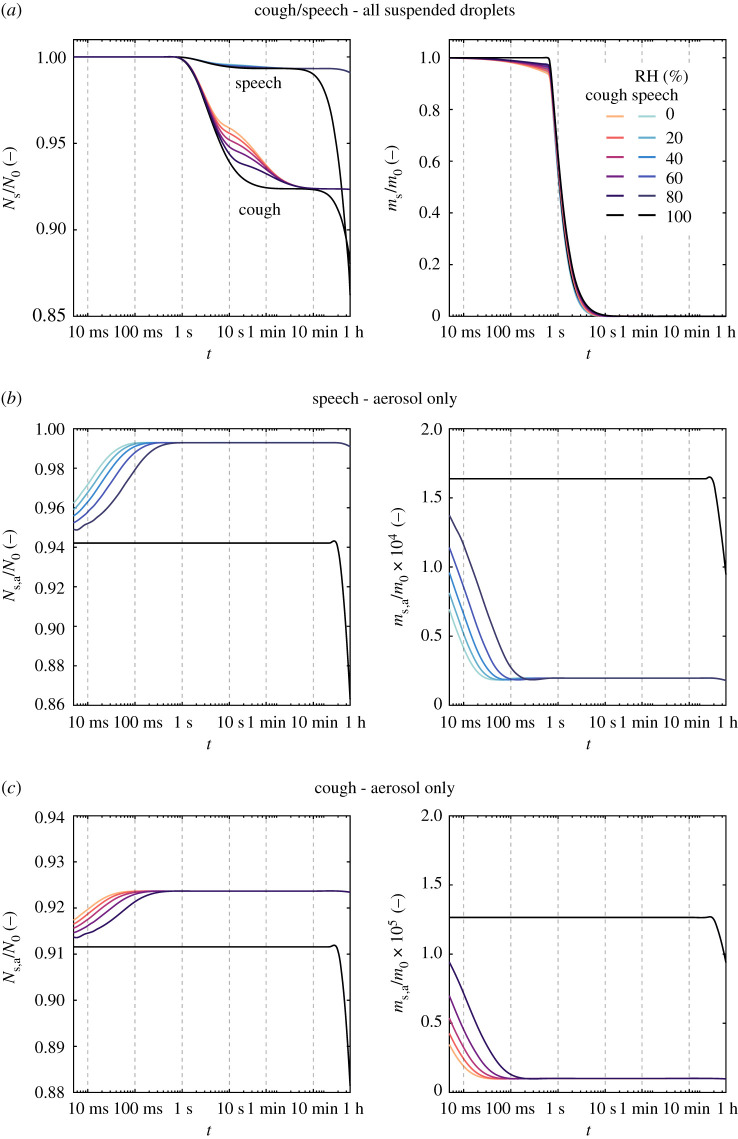
Time evolution of ensemble quantities (total mass and number) normalized by the respective value at t = 0 for sprays exhaled by speech and cough—T = 20°C, RH = 0–100%. In the top row, ensemble quantities shown are evaluated for all suspended droplets, while in the middle and lower low the quantities are calculated considering only droplets below 5 μm. More detail on the time evolution of ms/m0 is provided in figure 5. (Online version in colour.)